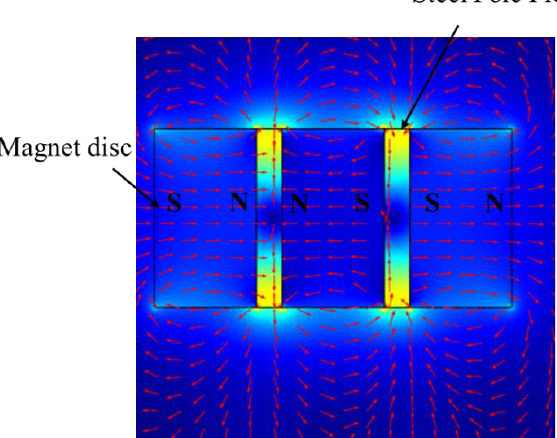
Figure 5. Generation of magnetic field on a roll magnetic separator.